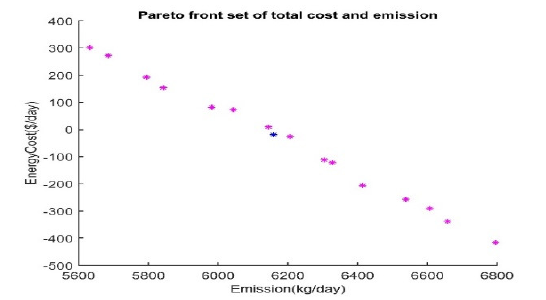
Fig. 8: Pareto Optimal Sets of Cost and